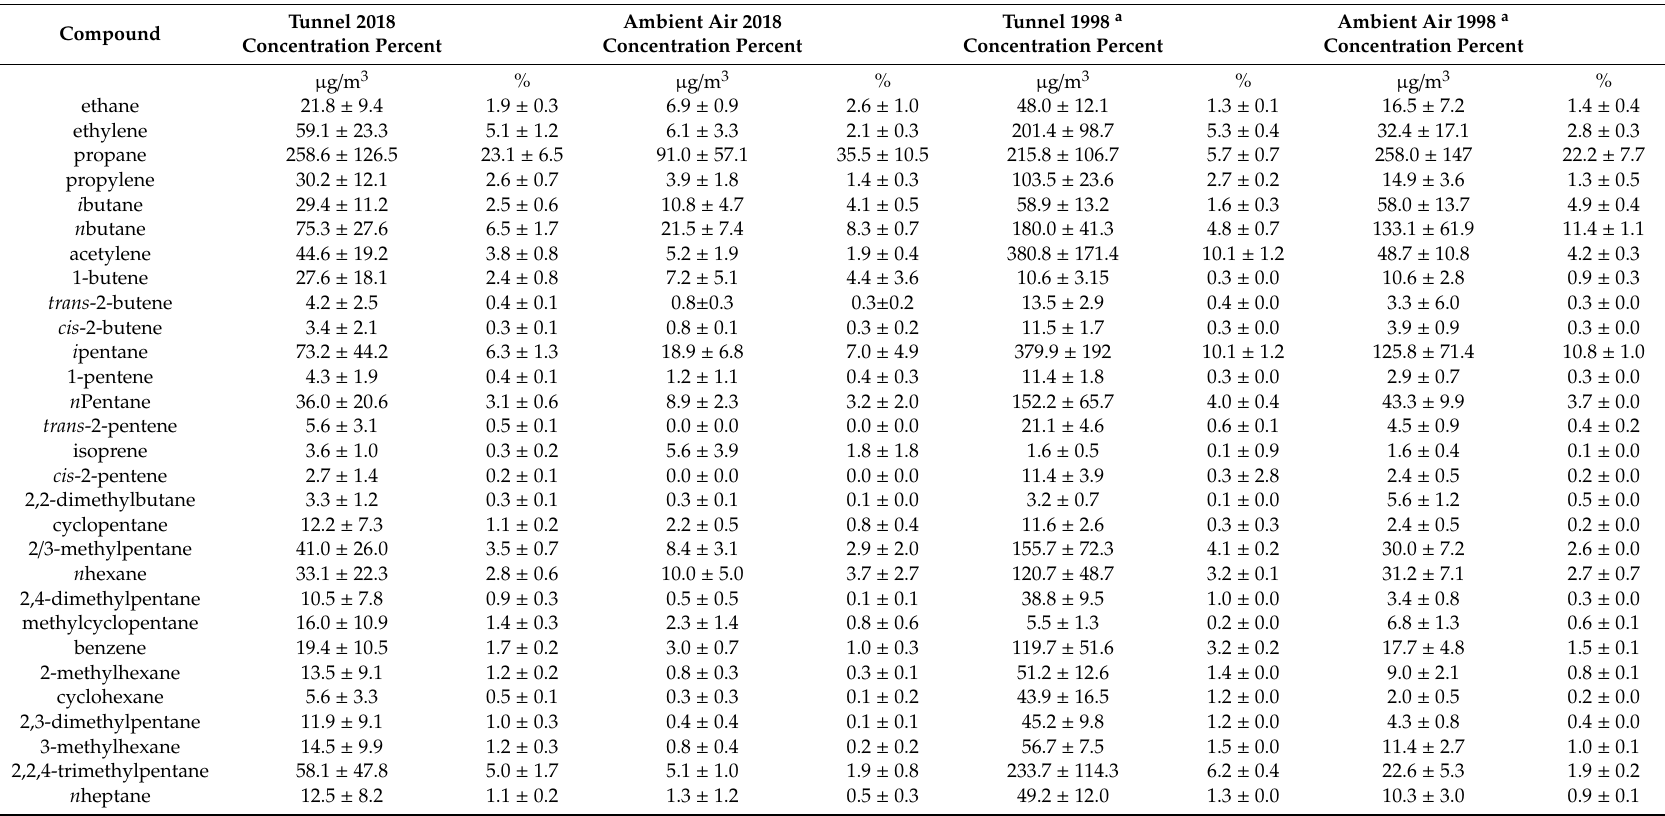
Table 2. Average and standard deviations of the concentrations and